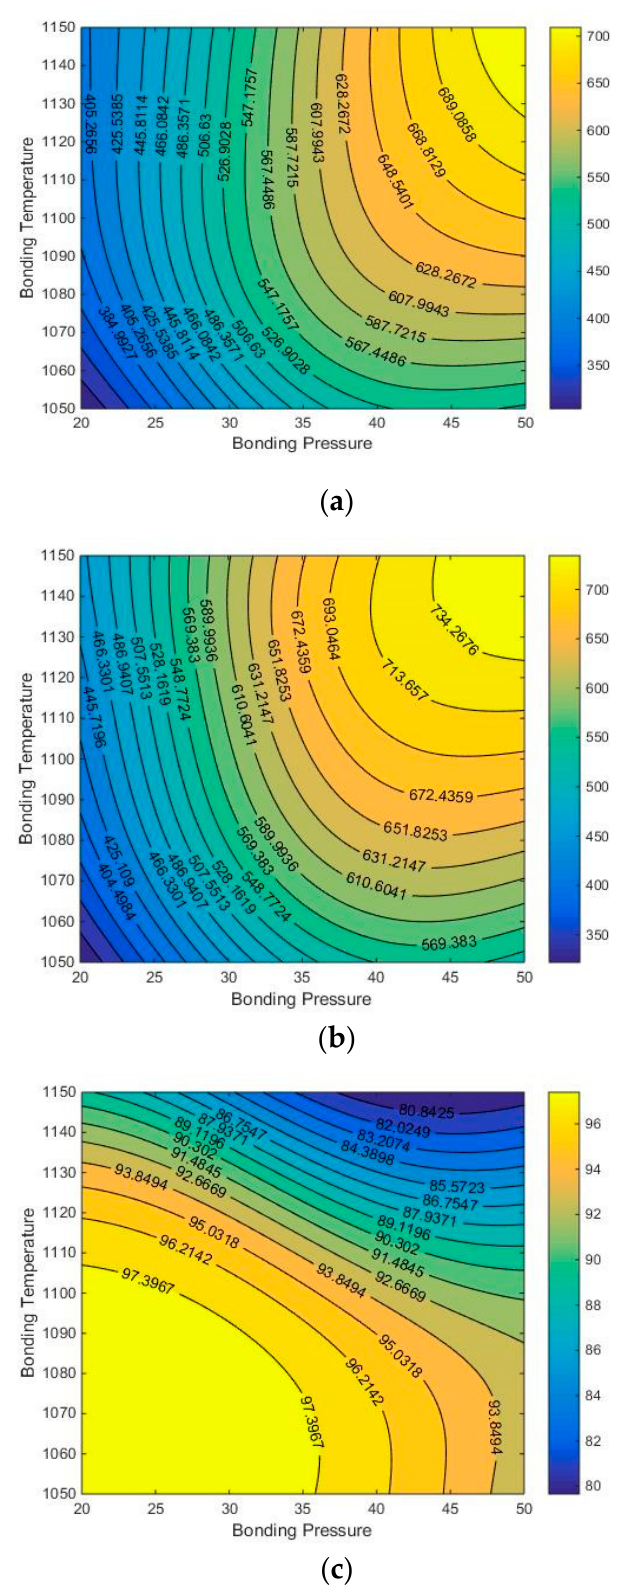
Figure 7. The double-factors contour map of tensile strength: ( a ) t = 30 min; ( b ) t = 60 min; ( c ) t = 90 min.